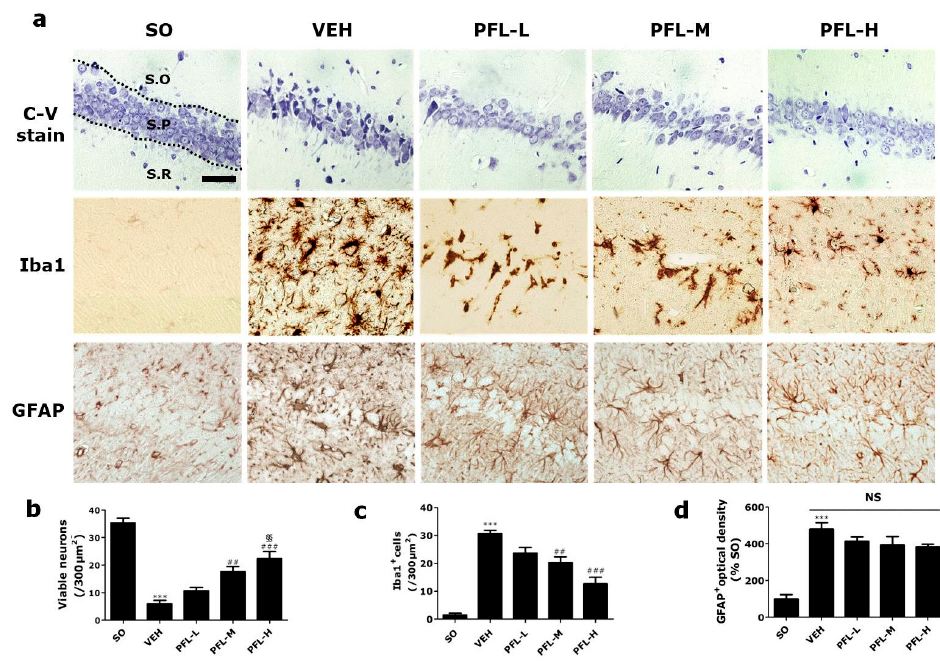
Figure 4. Effects of PFL on neuronal viability and neuroinflammation in the VaD rat hippocampal CA1. After cresyl violet staining ( a , top row) and immunohistochemistry against Iba1 ( a , middle row) and GFAP (a, bottom row), representative photographs of hippocampal CA1 were obtained, and the number of ( b ) viable neurons, ( c ) Iba1 + microglia, and ( d ) optical density of GFAP + astrocytes were quantified, respectively. The region of interest was within a 300 μ m width in the hippocampal CA1 region. In ( a ), the three layers of the hippocampus, i.e., stratum oriens, stratum pyramidale, and stratum radiatum, are indicated as “S.O”, “S.P”, and “S.R”, respectively. Scale bar = 50 μ m. In ( b ) to ( d ), values are presented as the mean ± SEM (*** p < 0.001 vs. SO; ## p < 0.01 and ### p < 0.001 vs. VEH; §§ p < 0.01 vs. PFL-L; NS, statistically not significant).